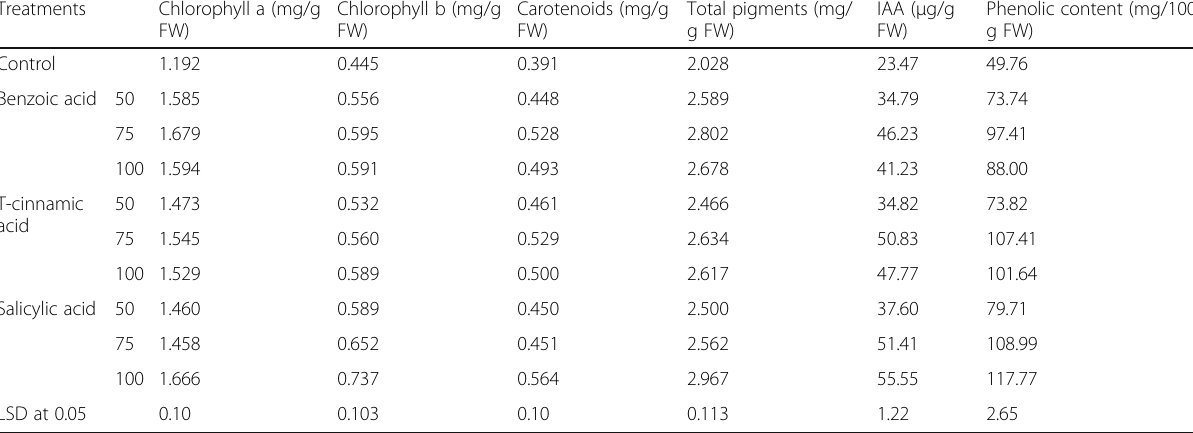
Table 18 Effect of benzoic, t-cinnamic, and salicylic acids levels on some biochemical constituents of flax plants grown under sandy soil conditions (data are means of two successive seasons) Treatments